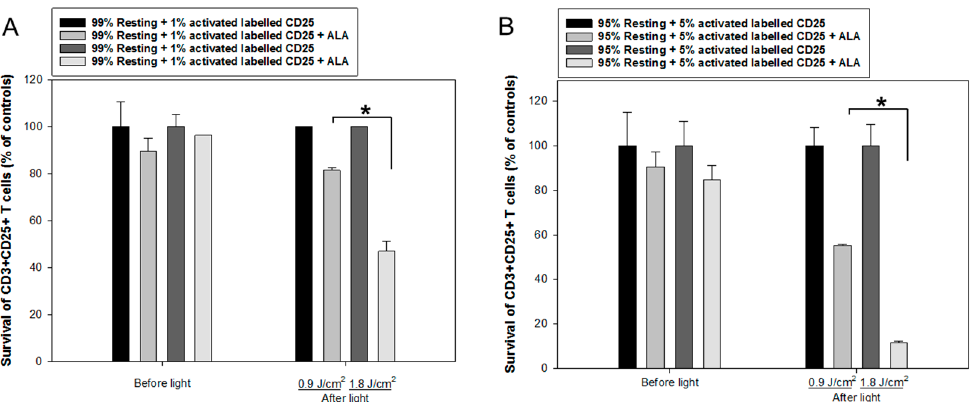
Figure 7. ALA-PDT of mixed populations of resting and activated cells. Healthy donor PBMCs were activated in vitro with anti-CD3/CD28 antibodies for three days. The activated T cells were then labeled with anti-human CD25-FITC antibody. The resting and CD25-FITC labeled activated T cells were mixed in certain ratios as indicated. The mixed cells were incubated with 3 mM ALA for 1 h at 37 °C and then irradiated with the LED blue light at 0.9 J/cm 2 or 1.8 J/cm 2 . The cell survivals were measured 2 h after light irradiation with flow cytometry as described in Figure 3. The control samples without light are also included. ( A ) Mixture of 1% CD25-FITC labelled activated T cells with 99% resting PBMCs. ( B ) Mixture of 5% CD25-FITC labelled activated T cells with 95% resting PBMCs. * p < 0.05.